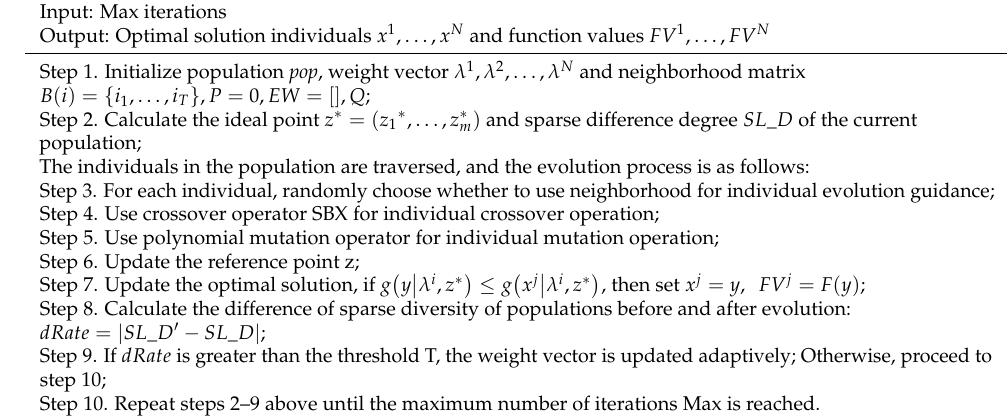
Table 2. Pseudo code of M-E-AWA